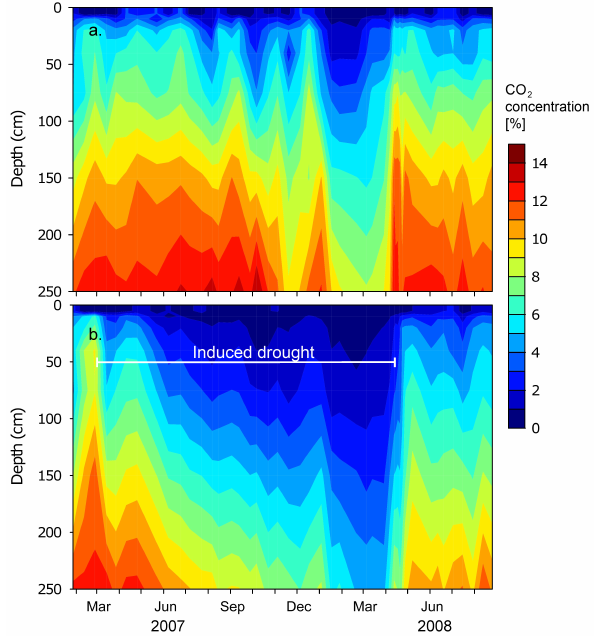
Fig. 6. Isopleths of average soil CO 2 concentrations (percent) in the soil profile of (a) control plots and (b) roof plots in soil air through- out the drought